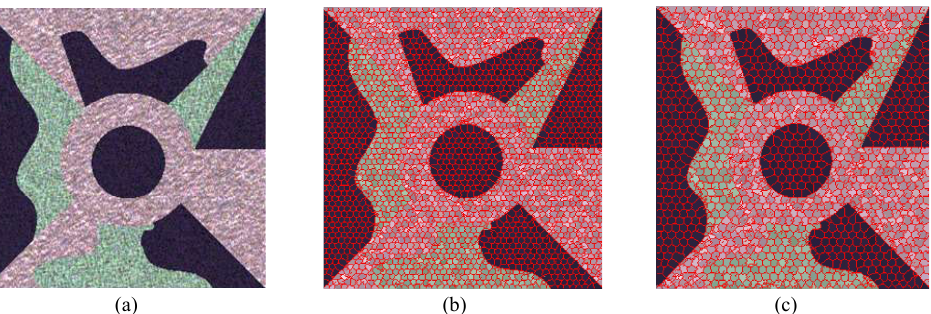
Figure 4. Results of IER based on hexagonal initialization of the 300 × 300 pixel simulated PolSAR image. ( a ) Pauli-RGB image. ( b ) Generated superpixels of N = 36; the RT is 32 s. ( c ) Generated superpixels of N = 64; the RT is 29 s.